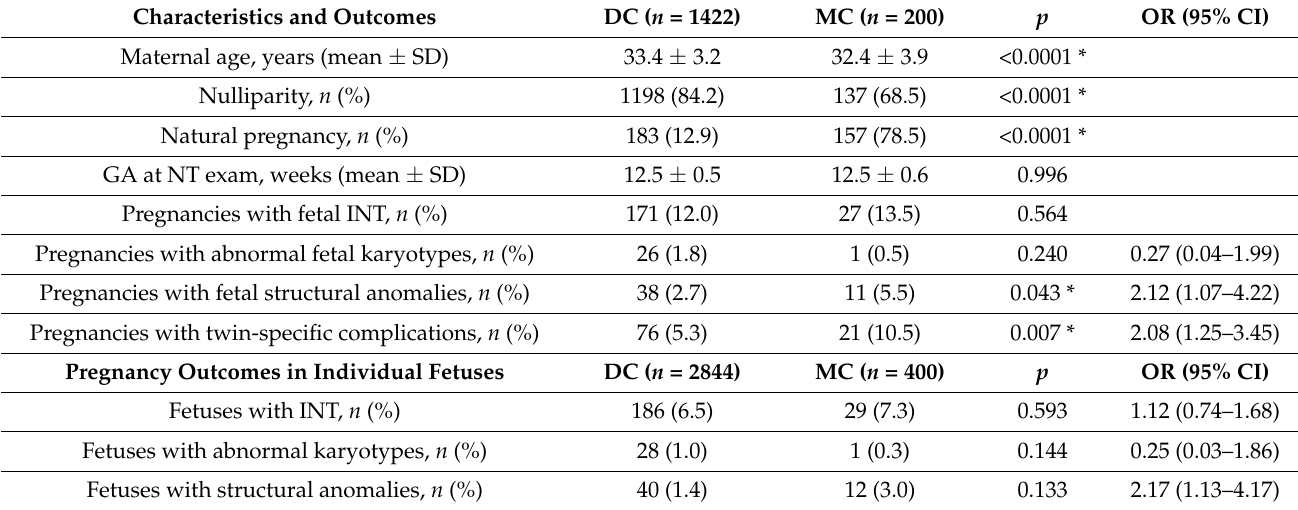
Table 3. Comparison of demographic characteristics and pregnancy outcomes in all twin pregnancies and individual fetuses based on the chorionicity.